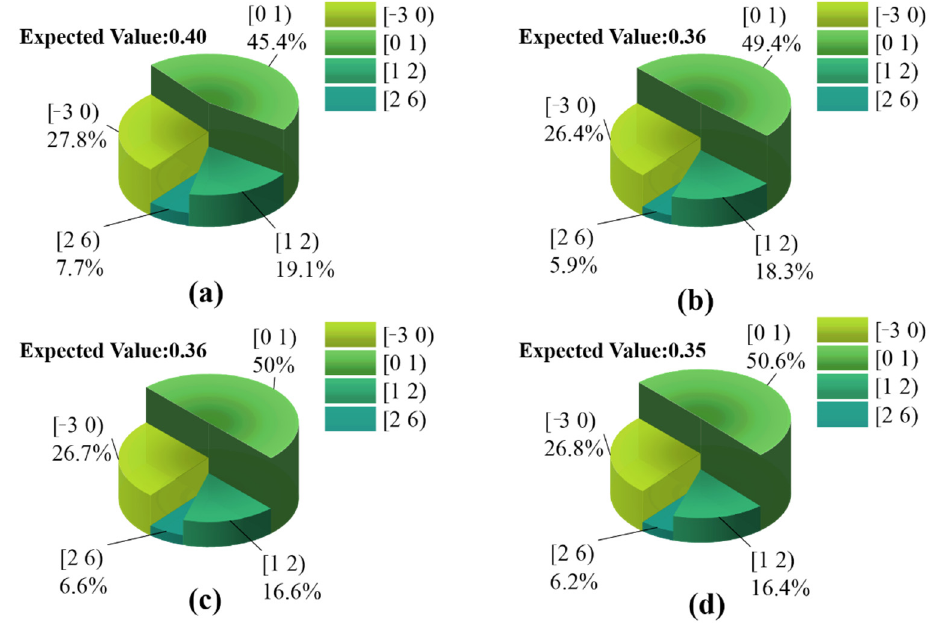
Figure 17. Distribution of equivalent fuel consumption per unit time. ( a ) RB strategy; ( b ) ECMS strategy; ( c ) MPC strategy; ( d ) H-EMS strategy.